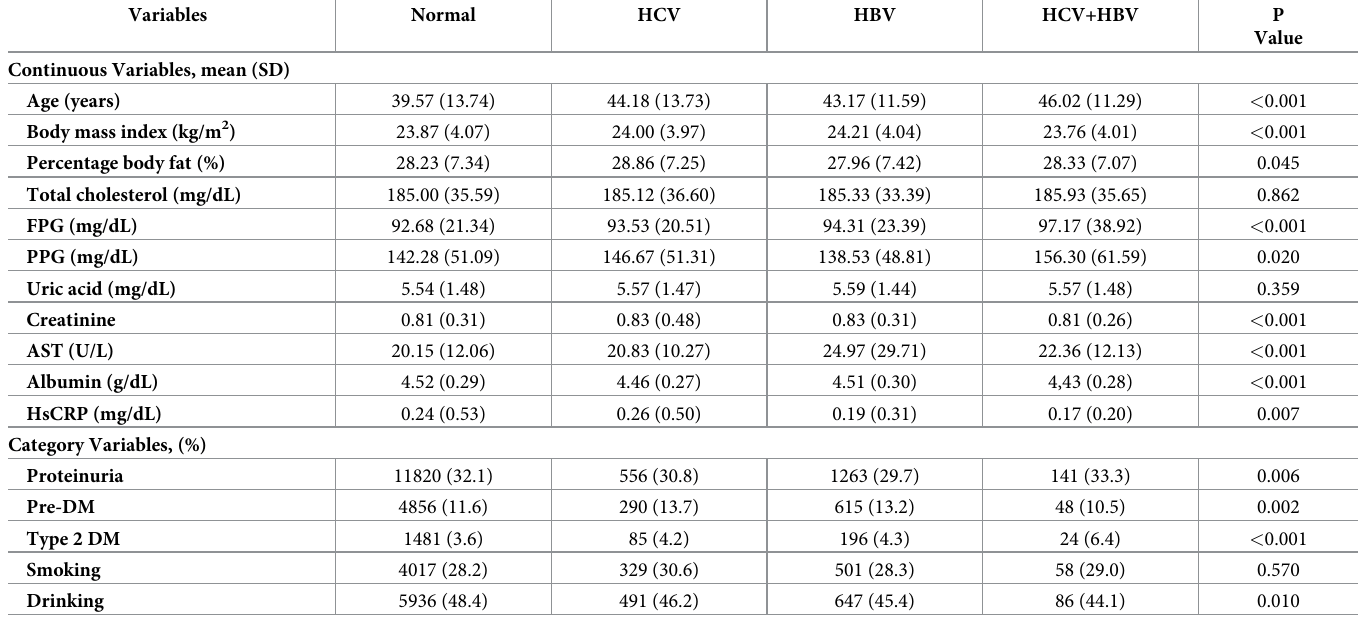
Table 1. Characteristics of study